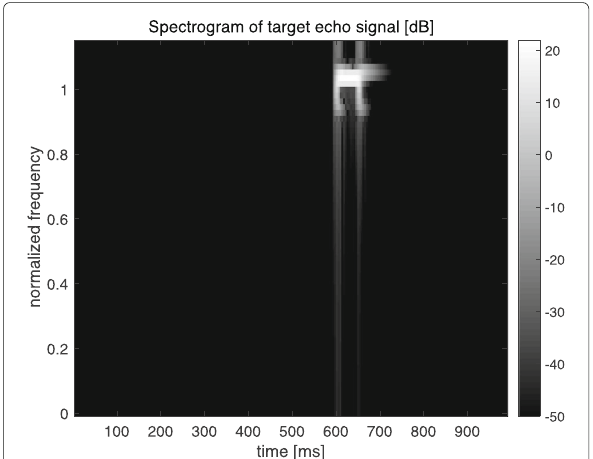
Fig. 2 Spectrogram of simulated target echo. The spectrum is well localized in frequency and time, allowing for target detection